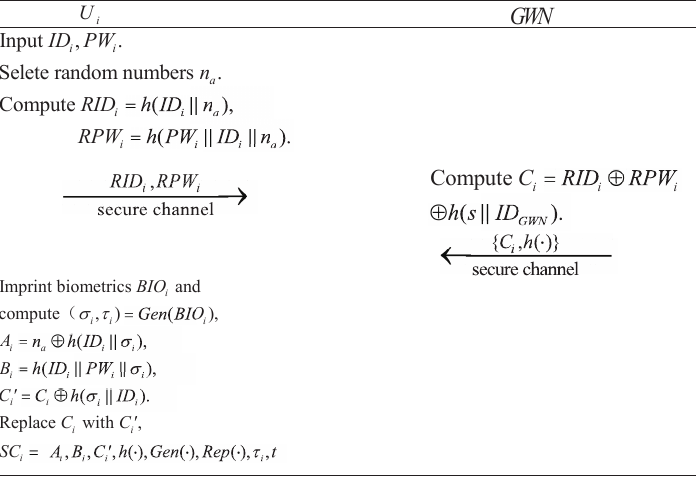
Figure 2. The user registration